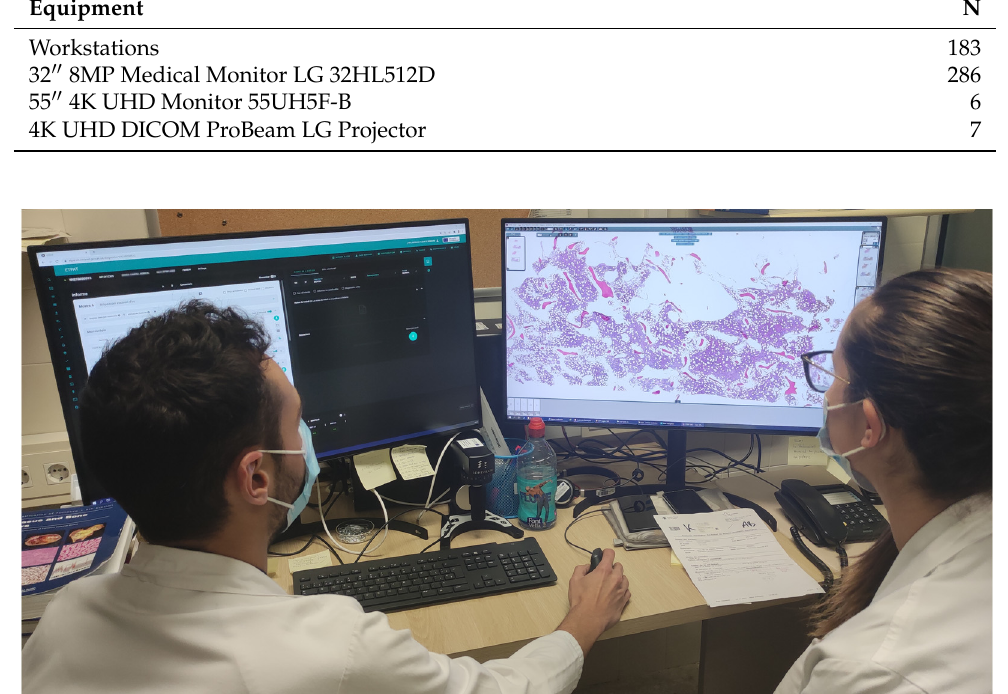
Figure 4. A pathologist in his office with a resident diagnosing with 2 LG 32HL512D 8MP diagnostic monitors.